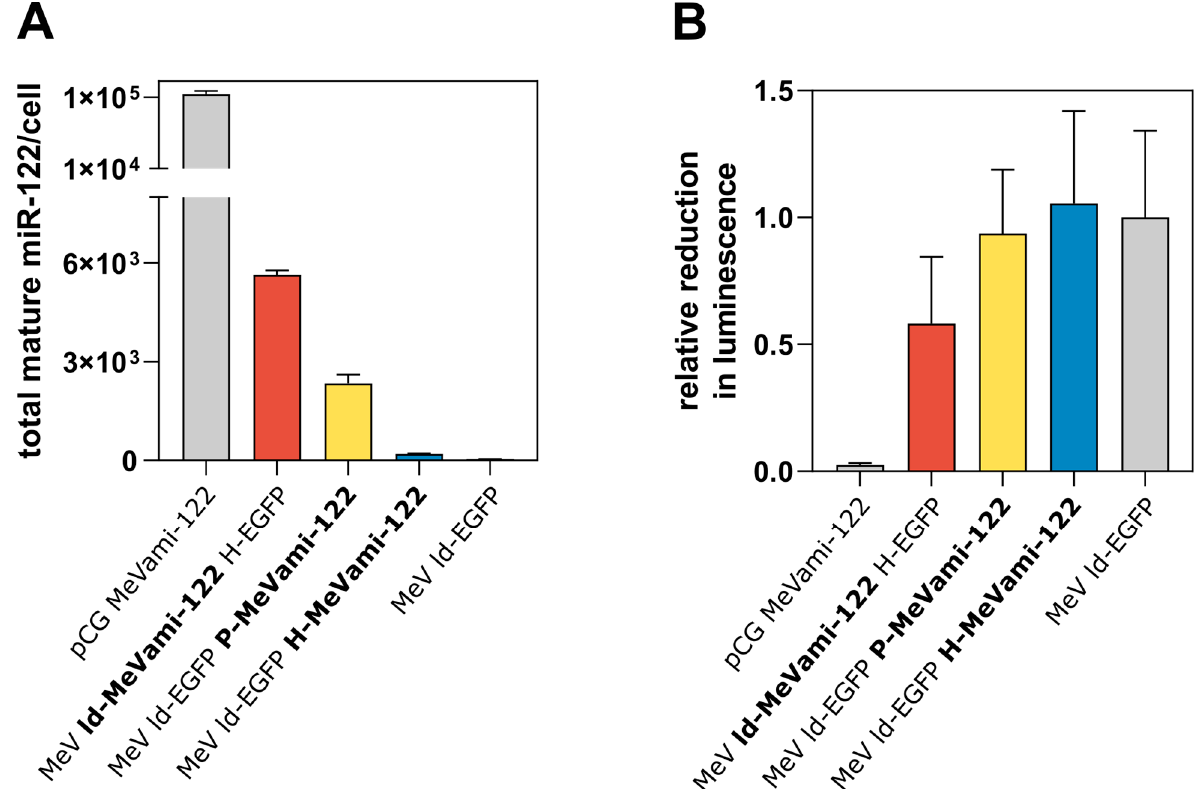
Figure 2. Expression of MiRNA and functional target protein suppression. ( A ) qPCR-based absolute quantification of miR-122 in cells transfected or infected with MeVami-122-encoding vectors. Vero cells were either transfected with 0.5 µg/mL pCG MeVami-122 or infected with MeVami-122-encoding viruses at MOI 0.3 and harvested 30 h p.t./p.i. qPCR was carried out in technical triplicates. Mean values are plotted. Error bars indicate standard deviation. ( B ) Target protein suppression in cells transfected or infected with MeVami-122-encoding vectors. Vero cells were transfected with psiCHECK™-2-miRTS-122 and either co-transfected with pCG MeVami-122 or infected with MeVami-122-encoding viruses at MOI 0.3 (6 h p.t.). Thirty h p.t./p.i. Renilla- and firefly luciferase-mediated luminescence was measured. Relative response ratios (RRRs) were calculated using negative (mock) and positive (miR-122) controls. Mean values of biological replicates ( n = 3) are plotted. Error bars indicate standard deviation. Values represent RRRs relative to the RRR of a control virus (MeV ld-EGFP).